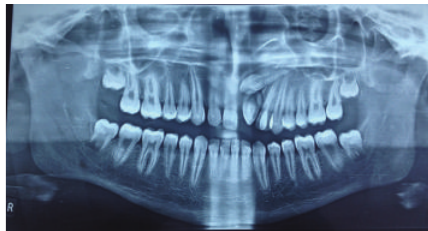
Figure 6: CBCT three-dimensional occlusal views depicting dilated odontoma and impacted central incisor.